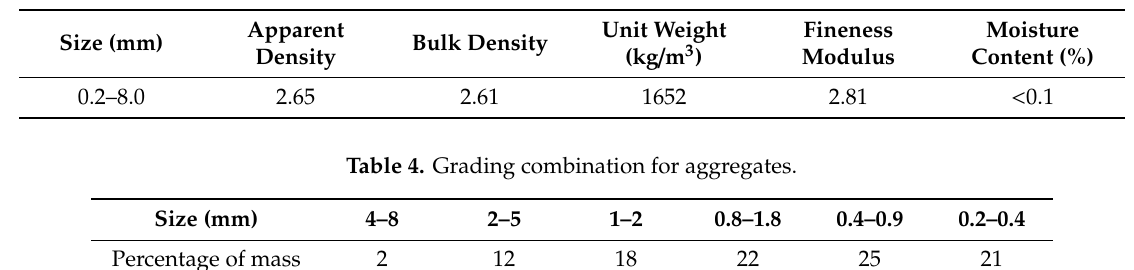
Table 3. Properties of siliceous aggregate.